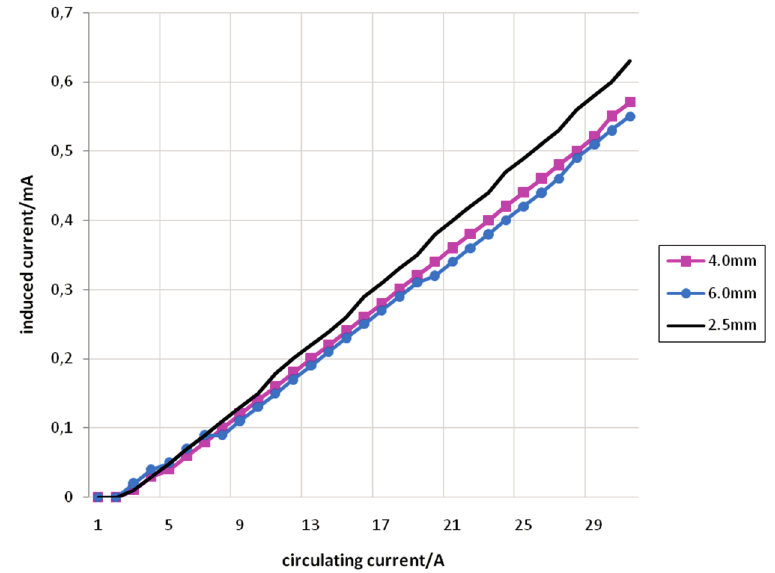
Figure 13. I f versus I i for 15 turns with conductors of 2.5 mm 2 (black), 4 mm 2 (pink), and 6 mm 2